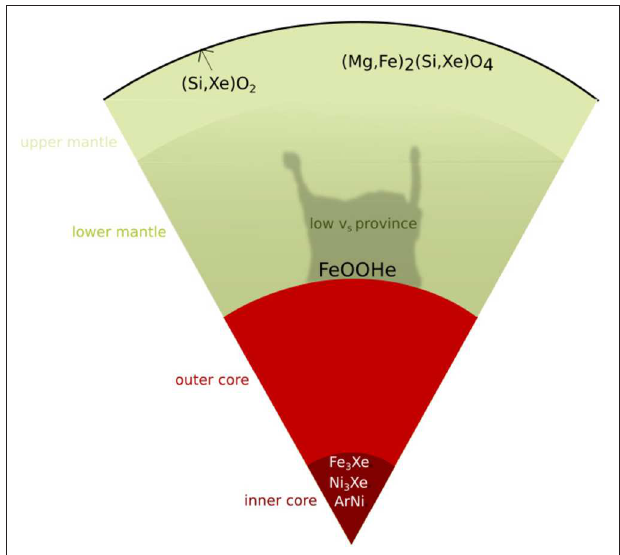
FIGURE 5 | Cartoon of Earth’s interiors and potential occurrence of noble gas-compounds at depth. Note that the Earth’s crust (black crust) is too thin to be represented at